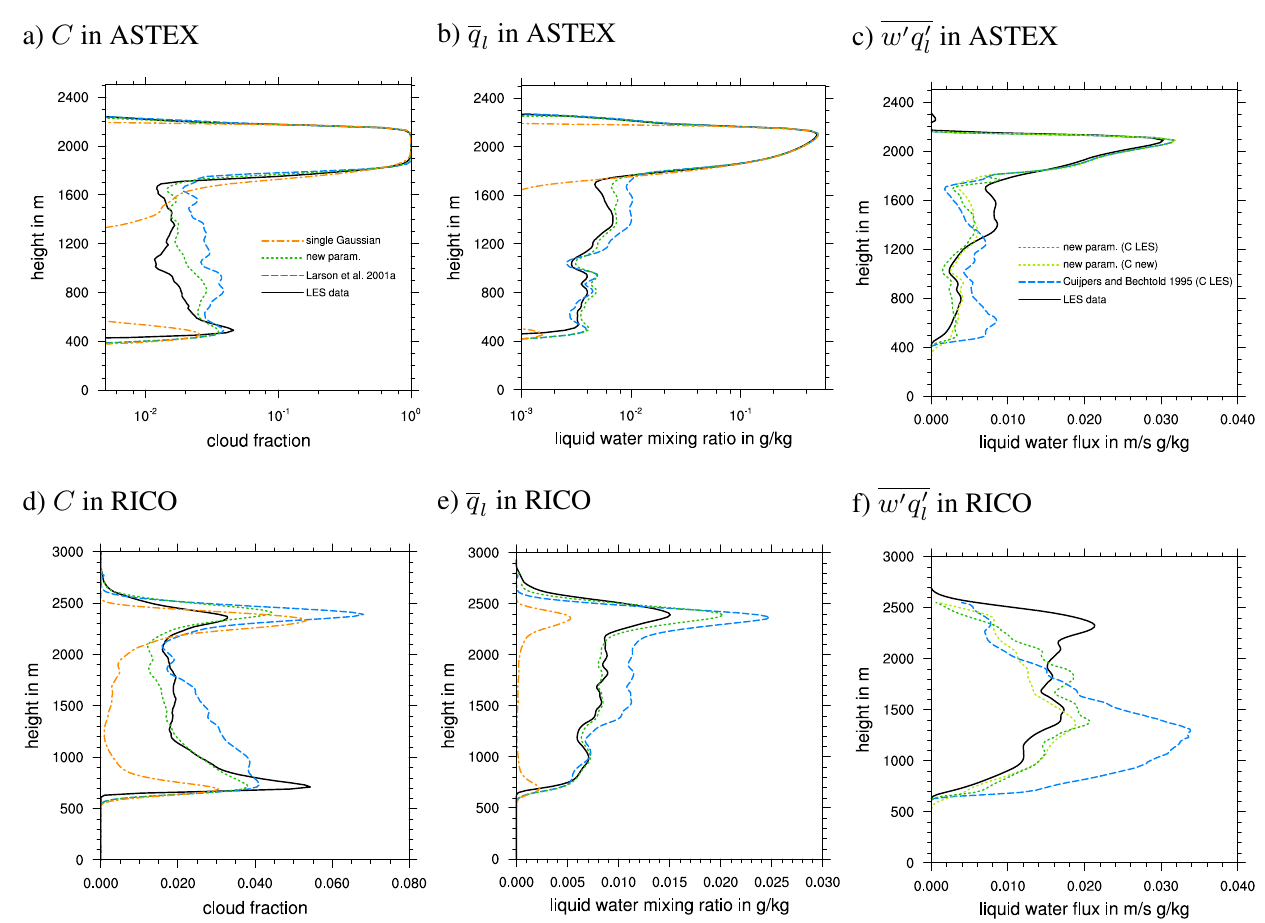
Fig. 7. Profiles of cloud fraction, average liquid water and the liquid water flux from LES cases ASTEX (testing dataset) after 25 h and RICO (training dataset) after 36 h of simulation. For the liquid water flux, C used in Eq. (10) has either been taken from the original LES data ( C LES) or from the new parameterization ( C new). The legend in (a) also applies to (b,d,e), the legend in (c) also applies to (f). Note the logarithmic scale on the x-axis in (a) and (b).